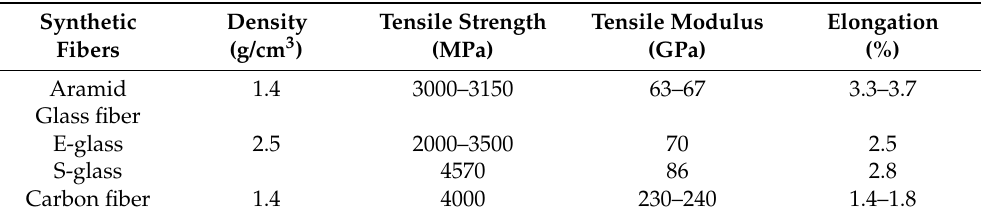
Table 5. Properties of glass fiber, carbon fiber, and Kevlar. Adapted from [49] with permission from Chaoyang University of Technology,